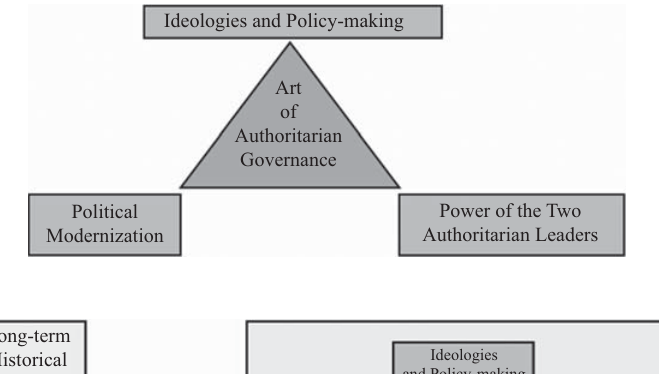
Figure 2. Establishment of